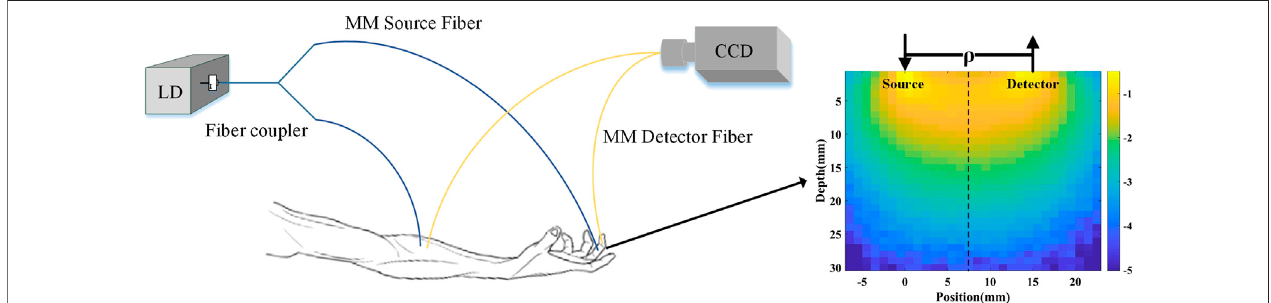
FIGURE 1 | Structure diagram of the MMF-DSCA